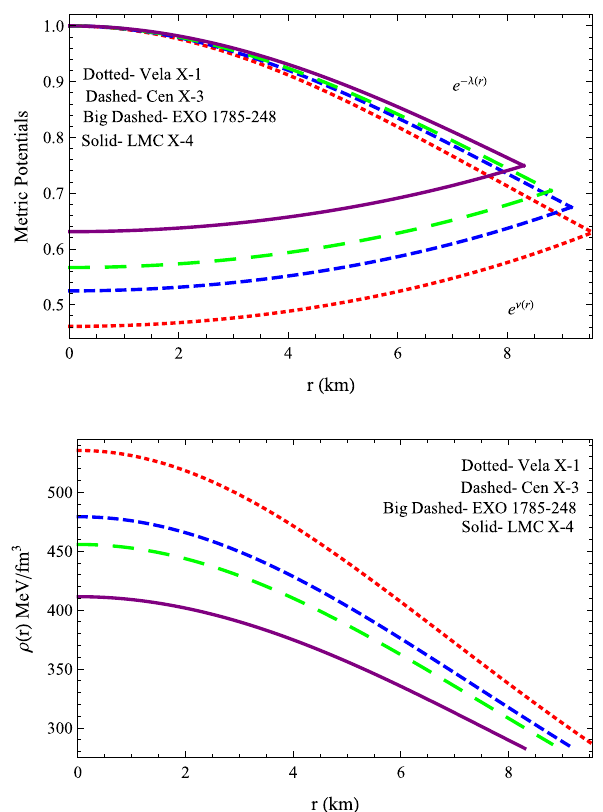
Fig. 1 Metric potential functions (above) and energy density (below) vstheradialcoordinate r correspondingtonumericalvaluesofconstants given in Table 2 for four well-known compact